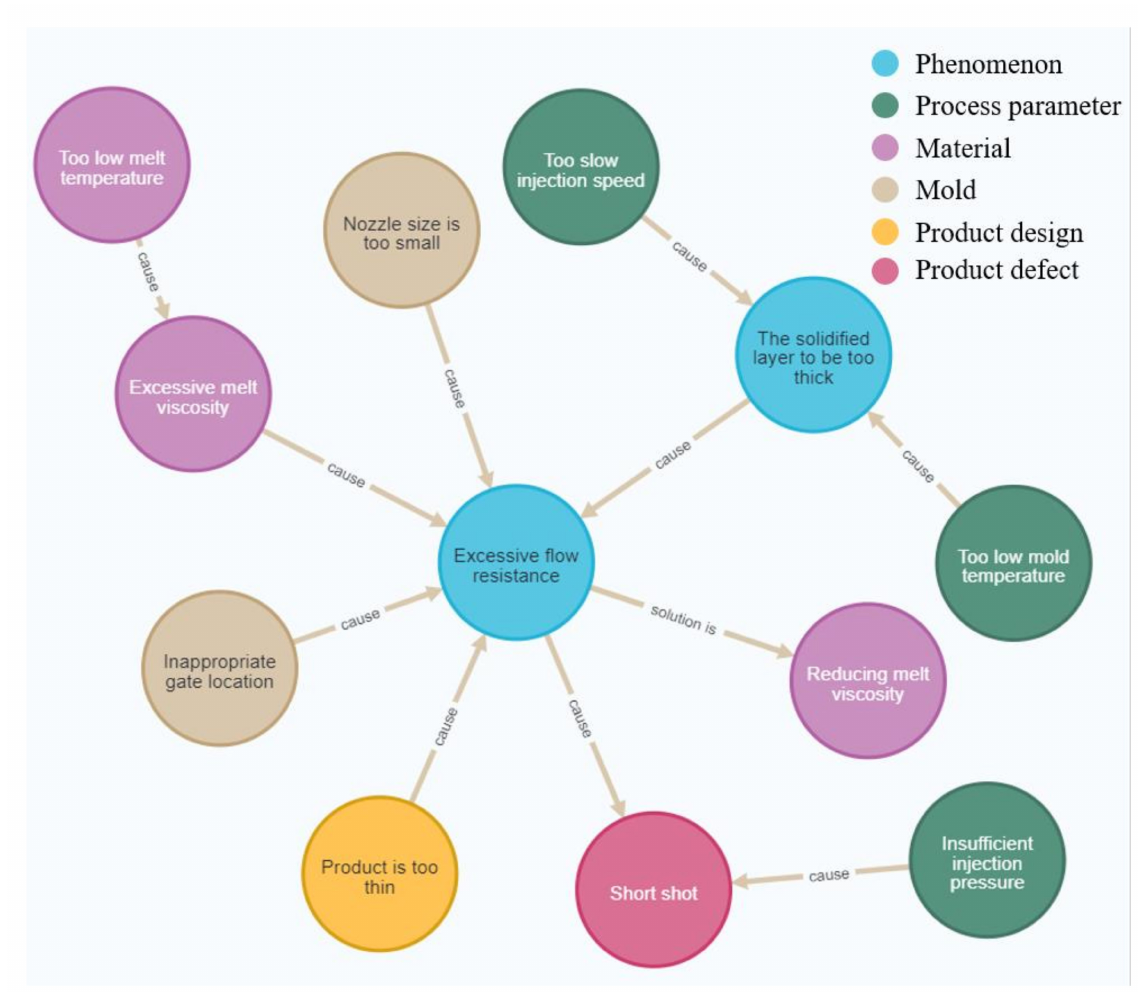
Figure 11. Results of all imported data